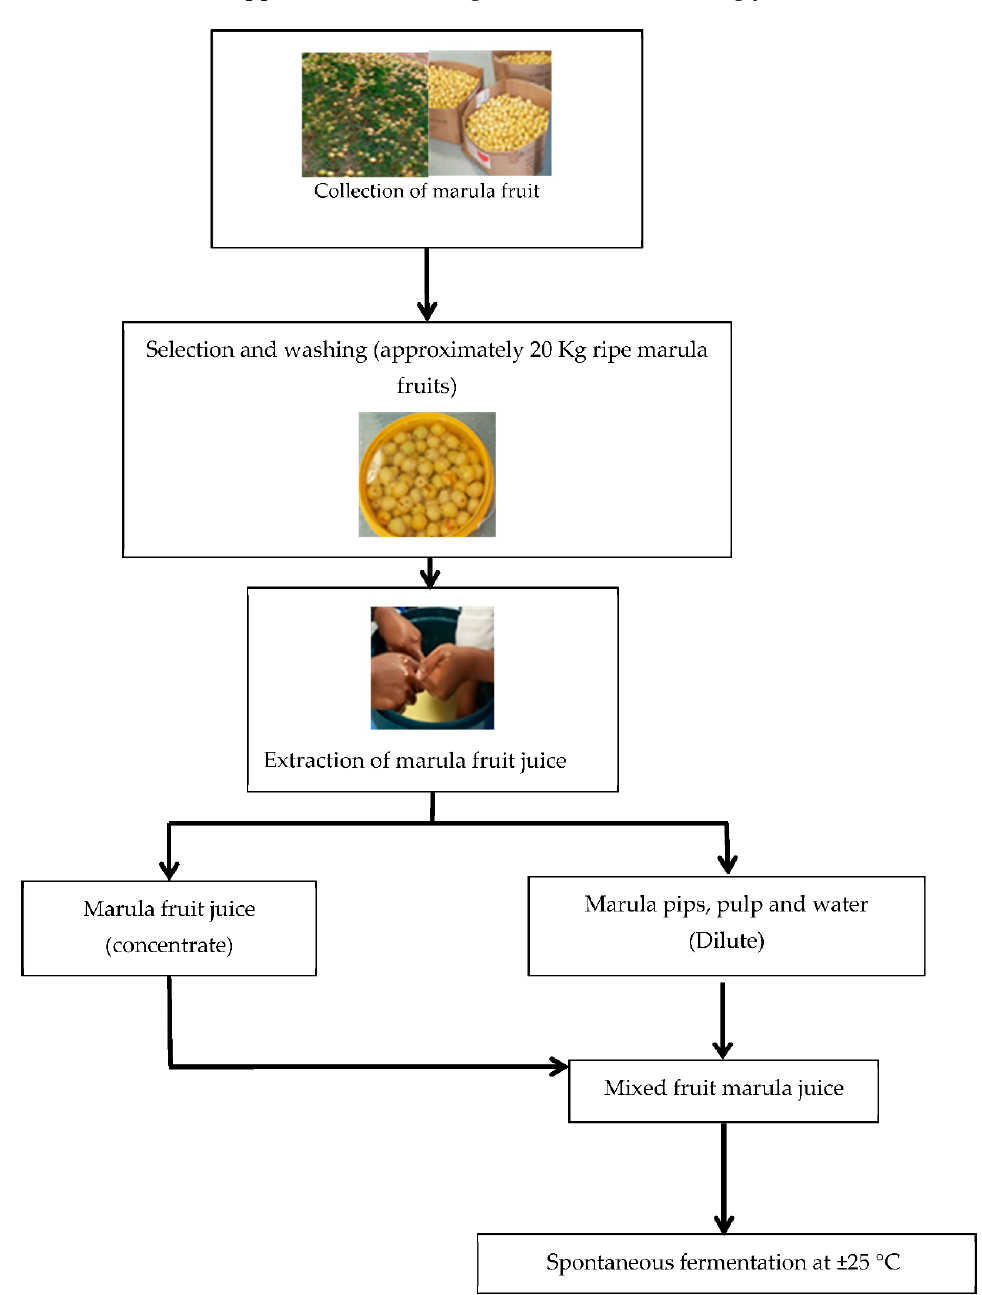
Figure 3. Production of marula wine from fruit.